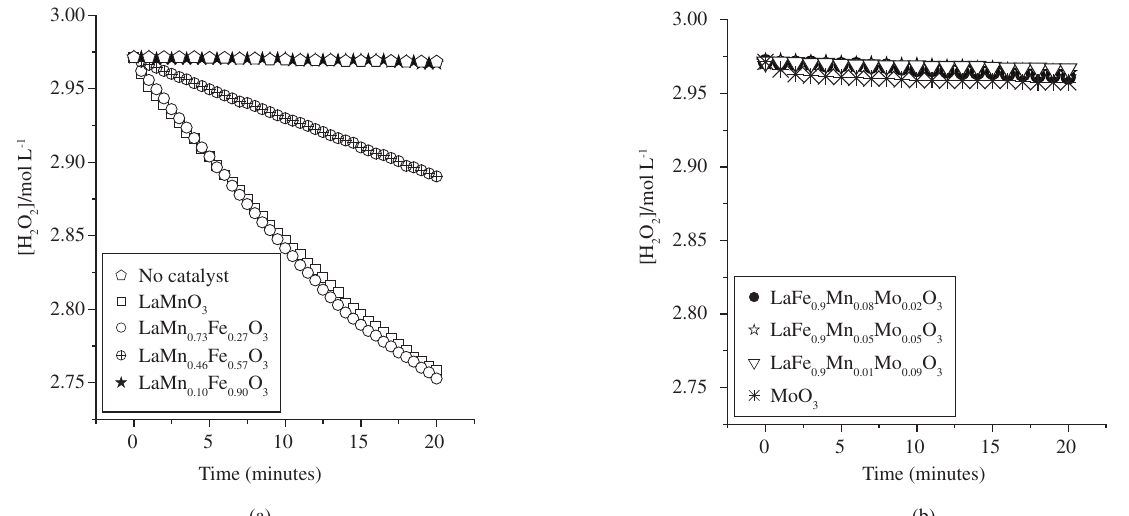
Figure 5. Hydrogen Peroxide decomposition in the presence of different perovskites LaMn catalyst 30 mg).